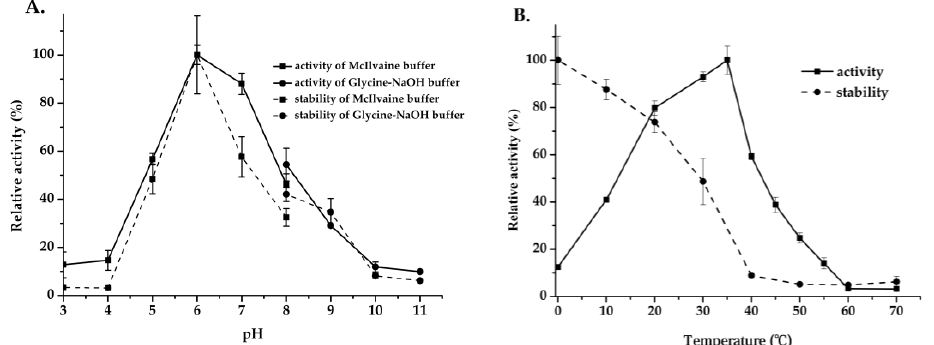
Figure 6. Effect of pH and temperature of Mg9373 on active and stability. ( A ) Effect of pH on active. The effect of pH on Mg9373 activity was determined at McIlvaine buffer between pH 3.0–8.0 and Glycine-NaOH buffer between pH 8.0–11.0, at 40 °C. ( B ) ffect of temperature on active and thermostability assay. The activity was determined in McIlvaine buffer (pH 7.0) at various temperatures (0–70 °C) and the thermostability of Mg9373 was determined after incubation at various temperatures (0–70 °C).